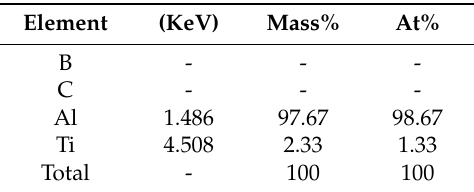
Table 2. Elemental mapping based on EDS spectrum for cast Al-5%TiB 2 sample (melt holding time of 20 min.